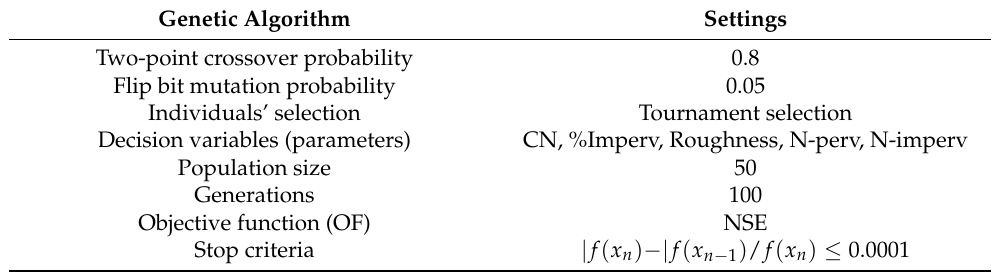
Table 1. Calibration settings.